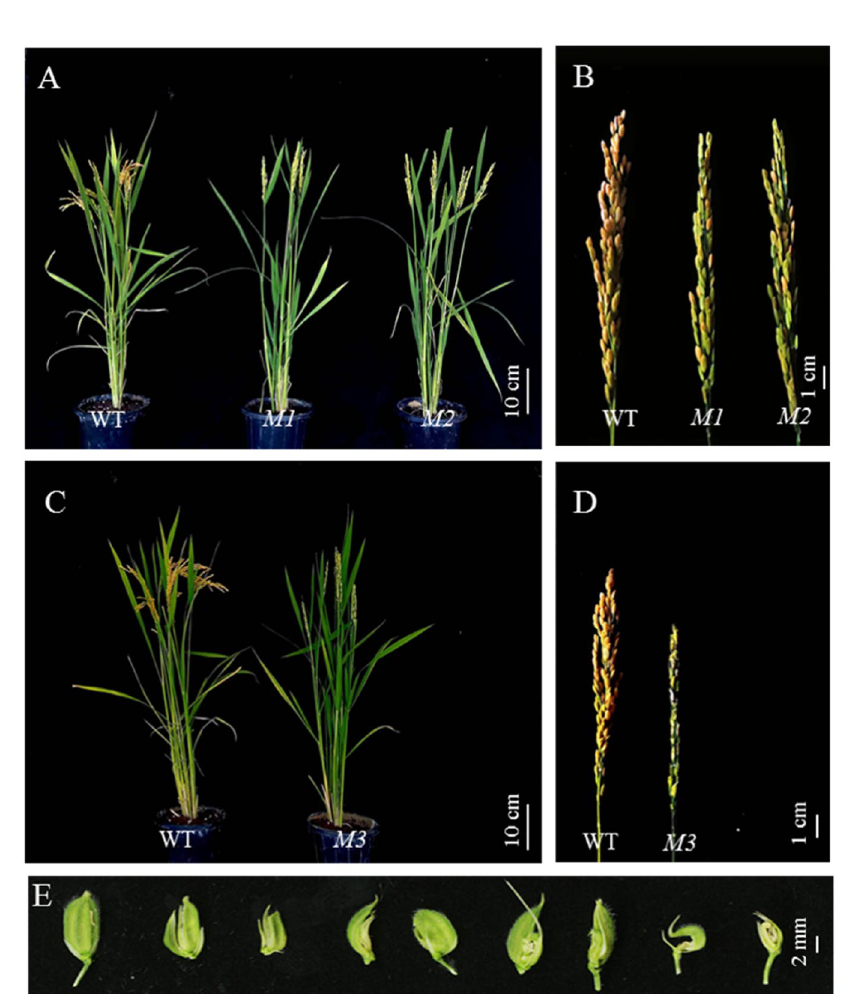
Figure 4. The Mutants of low filled grain percentage ( M1 and M2 ) and abnormal hull ( M3 ). ( A ) The plant type of M1 and M2 (right two) compared with WT (left); ( B ) The panicle shape of M1 and M2 (right two) compared with WT (left); ( C ) The plant type of M3 (right) compared with WT (left); ( D ) The panicle shape of M3 (right) compared with WT (left); and ( E ) The deformed glumes of M3 . WT, wild type, M1 , M2 and M3 were obtained from M 2 generations which were self-crossed from M 1 generations treated by DCEB of140 V, 48 h, 200 V, 48 h and 170 V, 48 h,